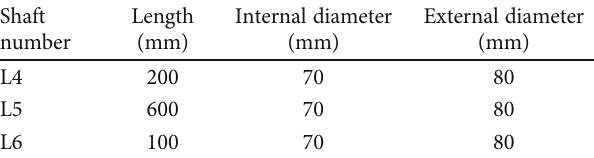
(b) Geometric parameters of a high-pressure rotor